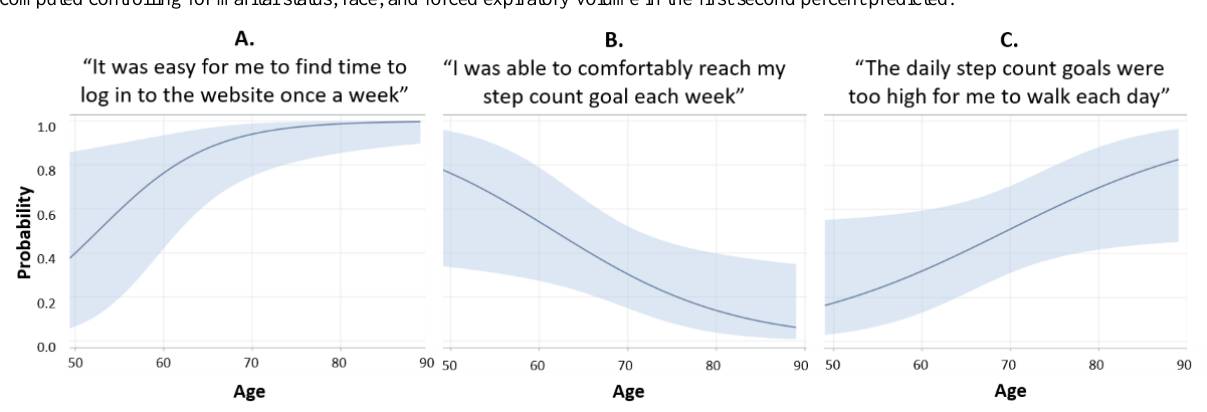
Figure 2. Predicted probability (logistic regression) of agreeing that (A) “It was easy for me to find time to log in to the website once a week”; (B) “I was able to comfortably reach my step count goal each week”; and (C) “The daily step goals were too high.” Figures include 95% confidence limits. Fit computed controlling for marital status, race, and forced expiratory volume in the first second percent